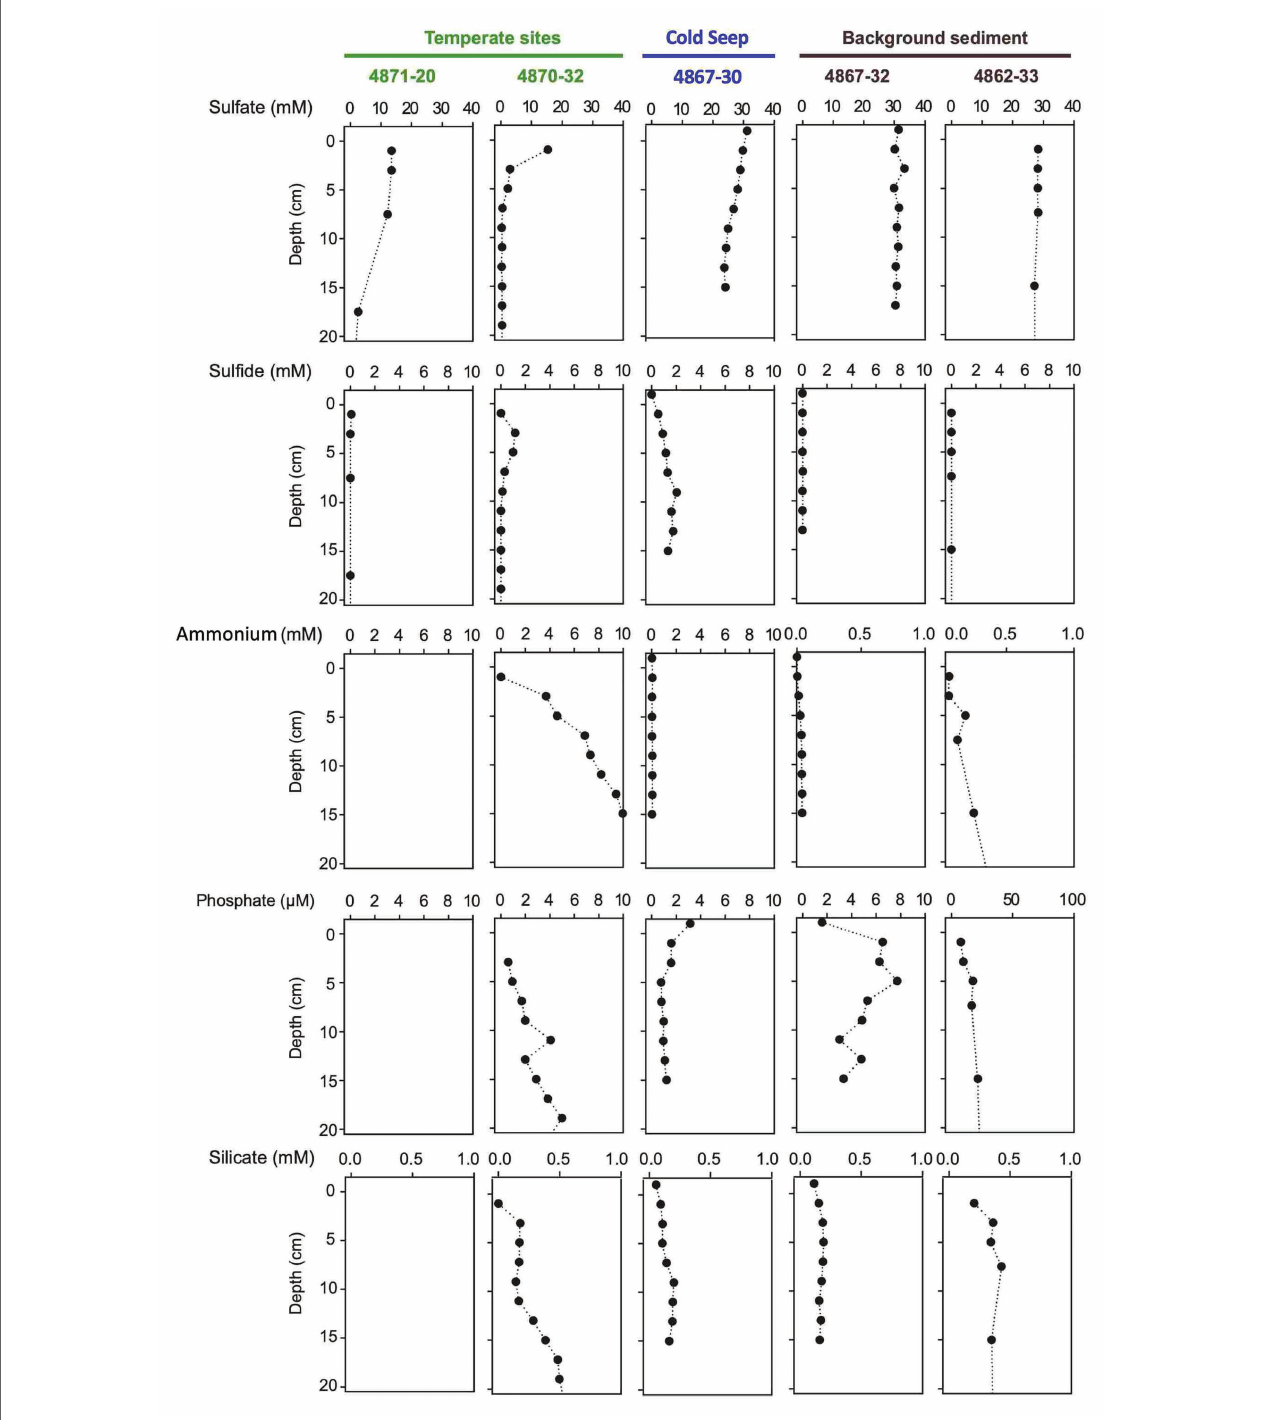
FIGURE 5 | Porewater concentration profiles of sulfate, sulfide, ammonium, phosphate, and silicate in two temperate cores, one seep core, and two background cores without visible microbial mats. Empty panels indicate data